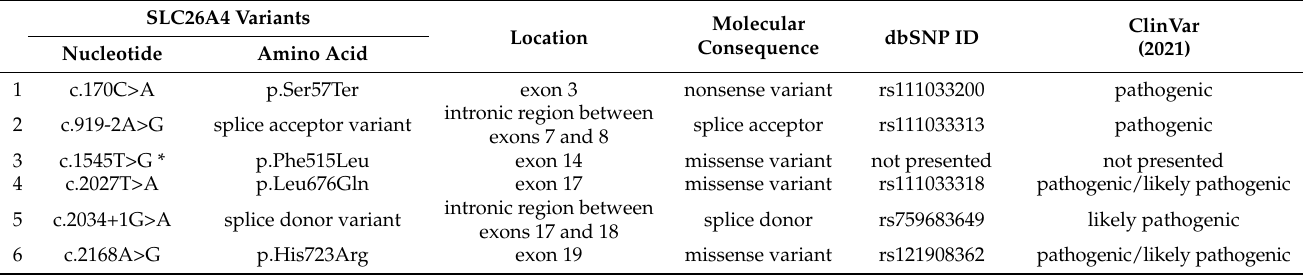
Table 2. Pathogenic variants in the SLC26A4 gene found in Tuvinian and Altaian patients. SLC26A4